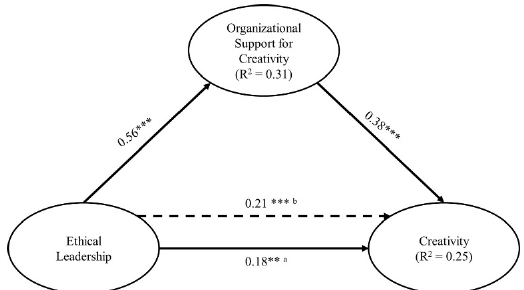
Figure 2. Structural equation model. Model adjustment index: chi2(274) = 304.31 p = 0.10; chi- squared test and degrees of freedom = 1.11; normed fit index = 0.95; comparative fix index = 0.99; root mean square error of approximation = 0.02; *** p < 0.001; ** p < 0.05; a: direct effect; b: indirect effect (source: created by